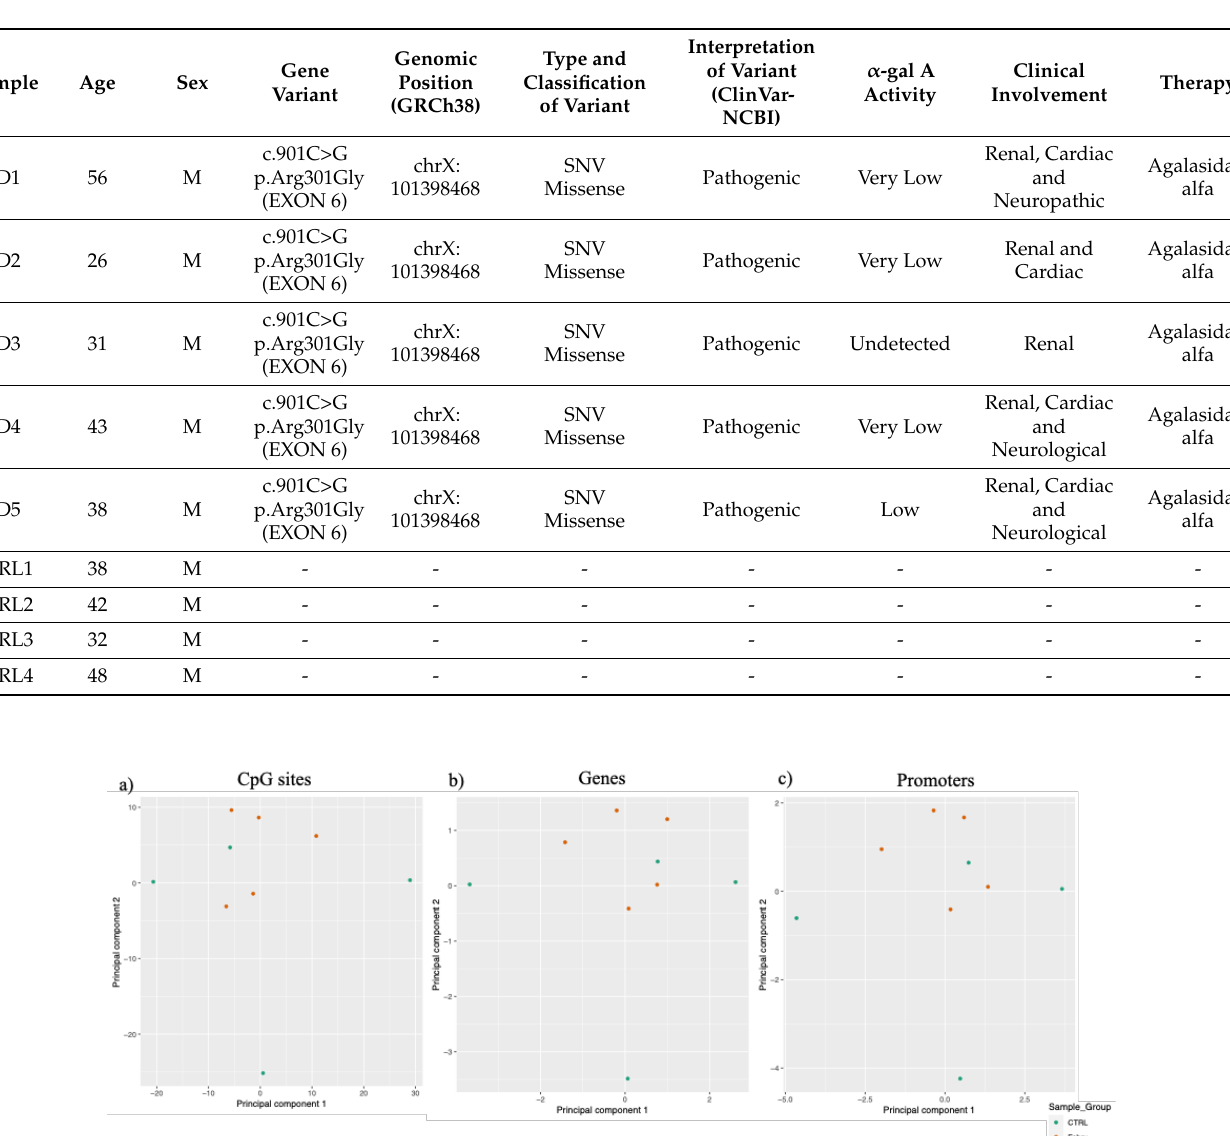
Table 1. Genetics and clinical characteristics of the study cohort. M = male; SNV = Single Nucleotide Variant.